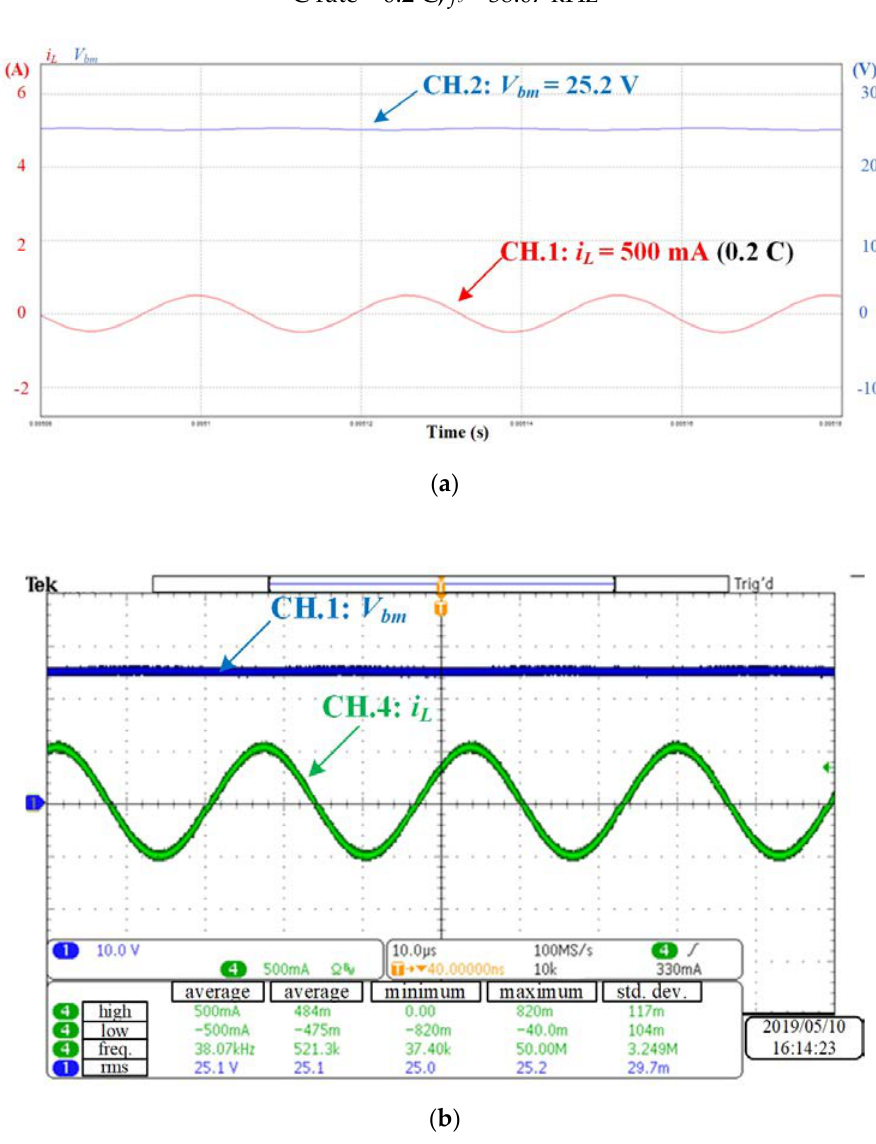
Figure 11. Measured and simulated waveforms of the proposed sinusoidal load under C rate = 0.2 C: ( a ) simulated waveforms; ( b ) measured waveforms.